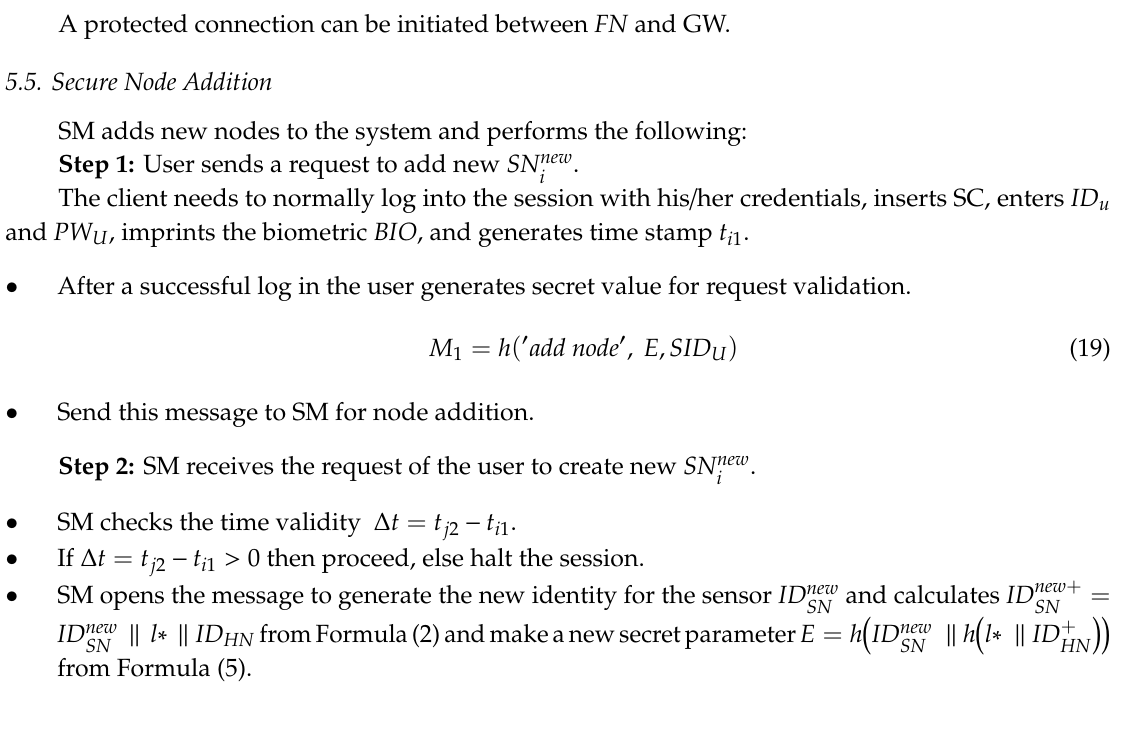
Figure 4. P-II: Three-factor re-authentication and key agreement protocol.